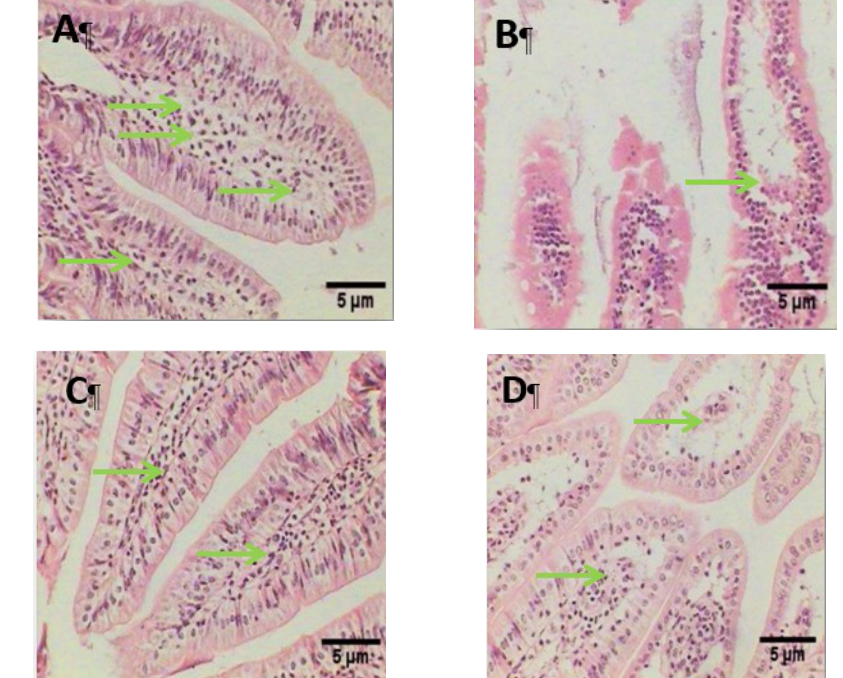
Figure 7. Photomicrograph of intestinal tissue stained with H&E stain (100×) showing ( A ) control group (G I), healthy structure in the mucosa layer (M), submucosa (S), muscularis, (MS), and normal healthy structure in the lamina propria (Lp) ( B ) Infected group (G II), showing a destructed villi (V) and degeneration of the lamina propria. ( C ) Infected group and treated at the same time with green Ag-NPs using G. mangostana (G III) showing an enhanced villus with very little degeneration of lamina propria. ( D ) The protected group, given green Ag-NPs using G. mangostana and after 1 week infected with L. monocytogenes (G IV) showing a destructed villus. Green arrows indicate lamina propria (Lp).